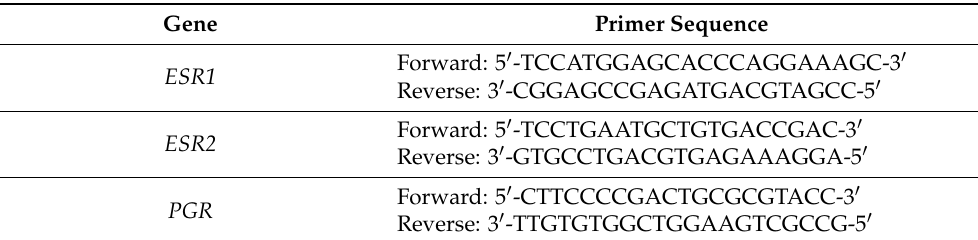
Table 4. Forward and reverse primer sequences used for estrogen receptor α ( ESR1 ) and estrogen receptor ß ( ESR2 ), and progesterone receptor ( PGR